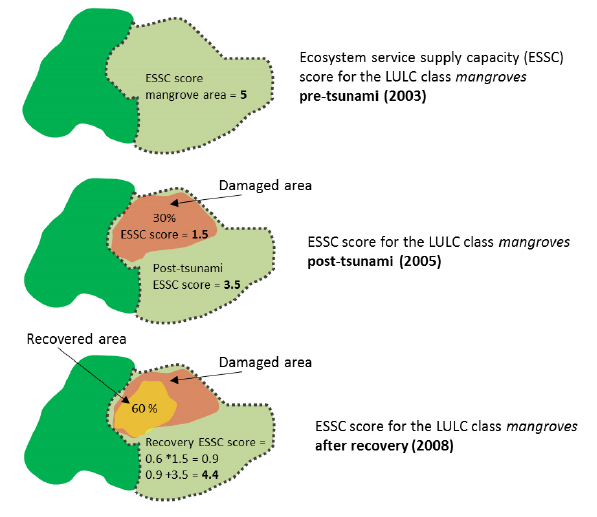
Fig. 5. Sketch describing the approach to calculate the ecosystem service supply capacity scores for the post-tsunami and the recovery phase (cf. Eqs. 1 and